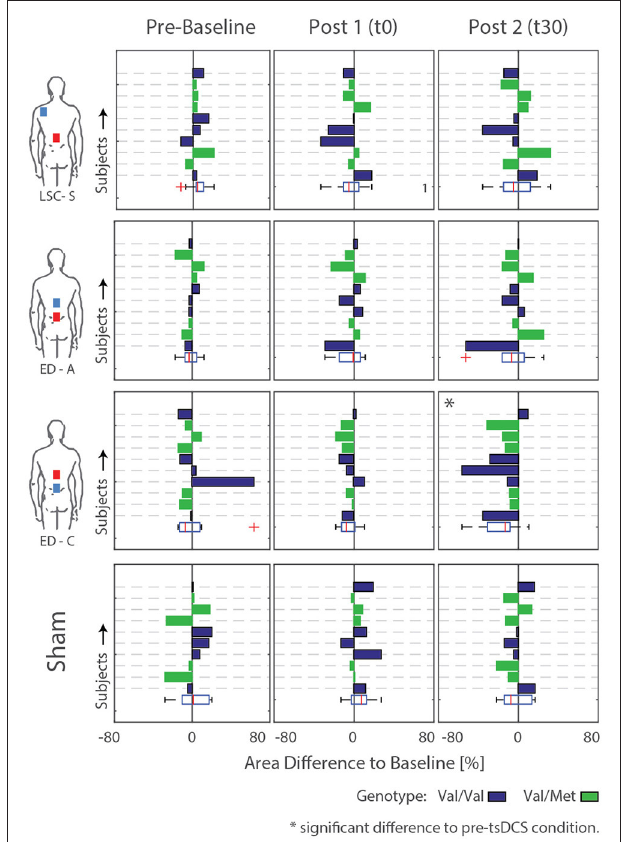
FIGURE 6 | Difference areas between baseline and pre-baseline as well as post tsDCS (t0 and t30) for all subjects. Rows/Bars within each graph correspond to the measured subjects. Additionally, the subject genotype is color coded: Val/Val Blue, Val/Met Green. Significant differences to = = pre-tsDCS measurements are detected for configuration ED-C at time t30.